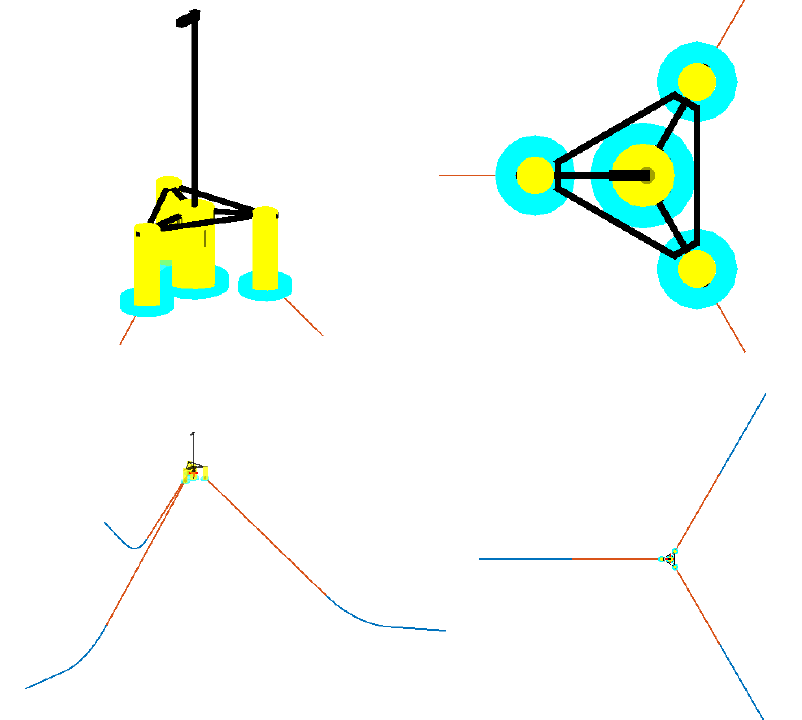
Figure 2. Jappaku FOWT mooring system by Edtools ® software in full